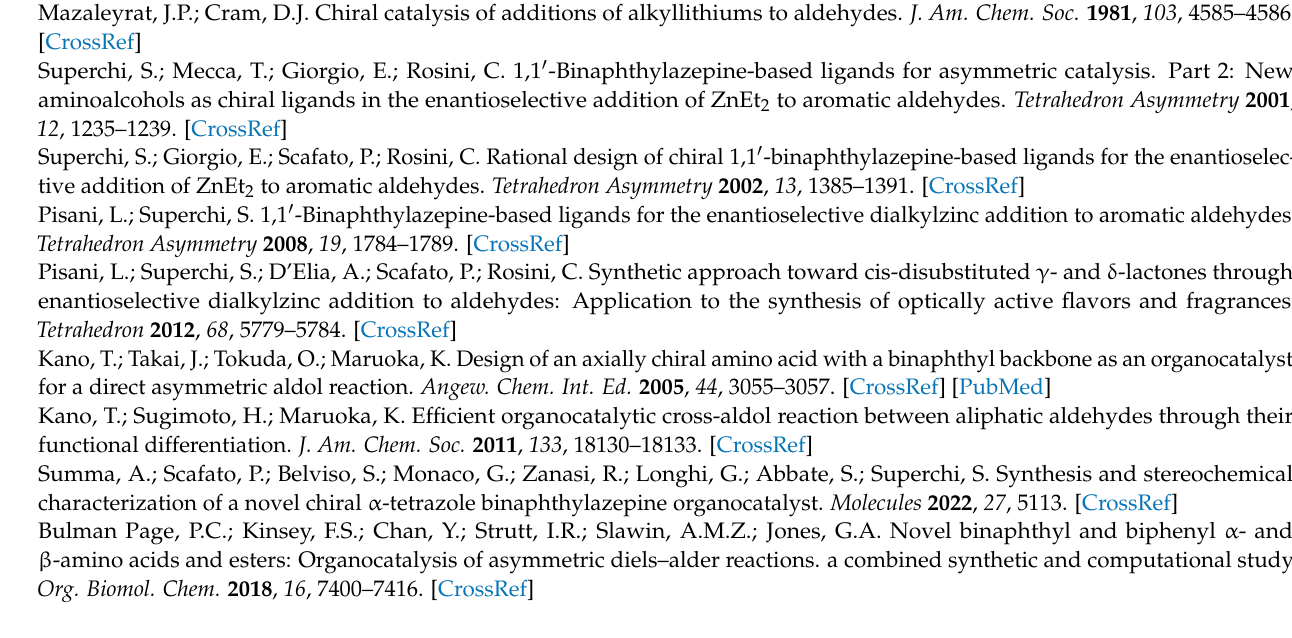
Figure S1: 1 H NMR spectrum of compound 3 ; Figure S2: 13 C NMR spectrum of compound 3 ; Figure S3: GC–MS analysis of compound 3 ; Figure S4: 1 H NMR spectrum of compound 4 ; Figure S5: 13 C NMR spectrum of compound 4 ; Figure S6: GC–MS analysis of compound 4 ; Figure S7: 1 H NMR spectrum of compound 5 ; Figure S8: 13 C NMR spectrum of compound 5 ; Figure S9: GC–MS analysis of compound 5 ; Figure S10: 1 H-NMR spectrum of compound 6 ; Figure S11: 13 C NMR spectrum of compound 6 ; Figure S12: GC–MS analysis of compound 6 ; Figure S13: GC–MS analysis of mixture of compounds 7 and 8 ; Figure S14: 1 H NMR spectrum of compound 8 ; Figure S15: 13 C NMR spectrum of compound 8 ; Figure S16: GC–MS analysis of compound 8 ; Figure S17: 1 H-NMR spectrum of compound 2 ; Figure S18: 13 C-NMR spectrum of compound 2 ; Figure S19: GC–MS analysis of compound 2